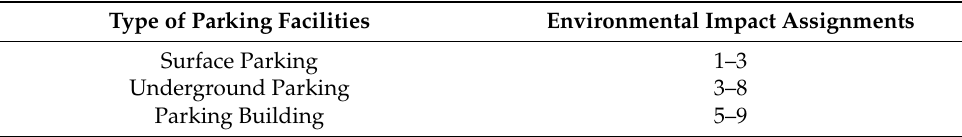
Table 4. Environmental impact assignment of parking facility types.